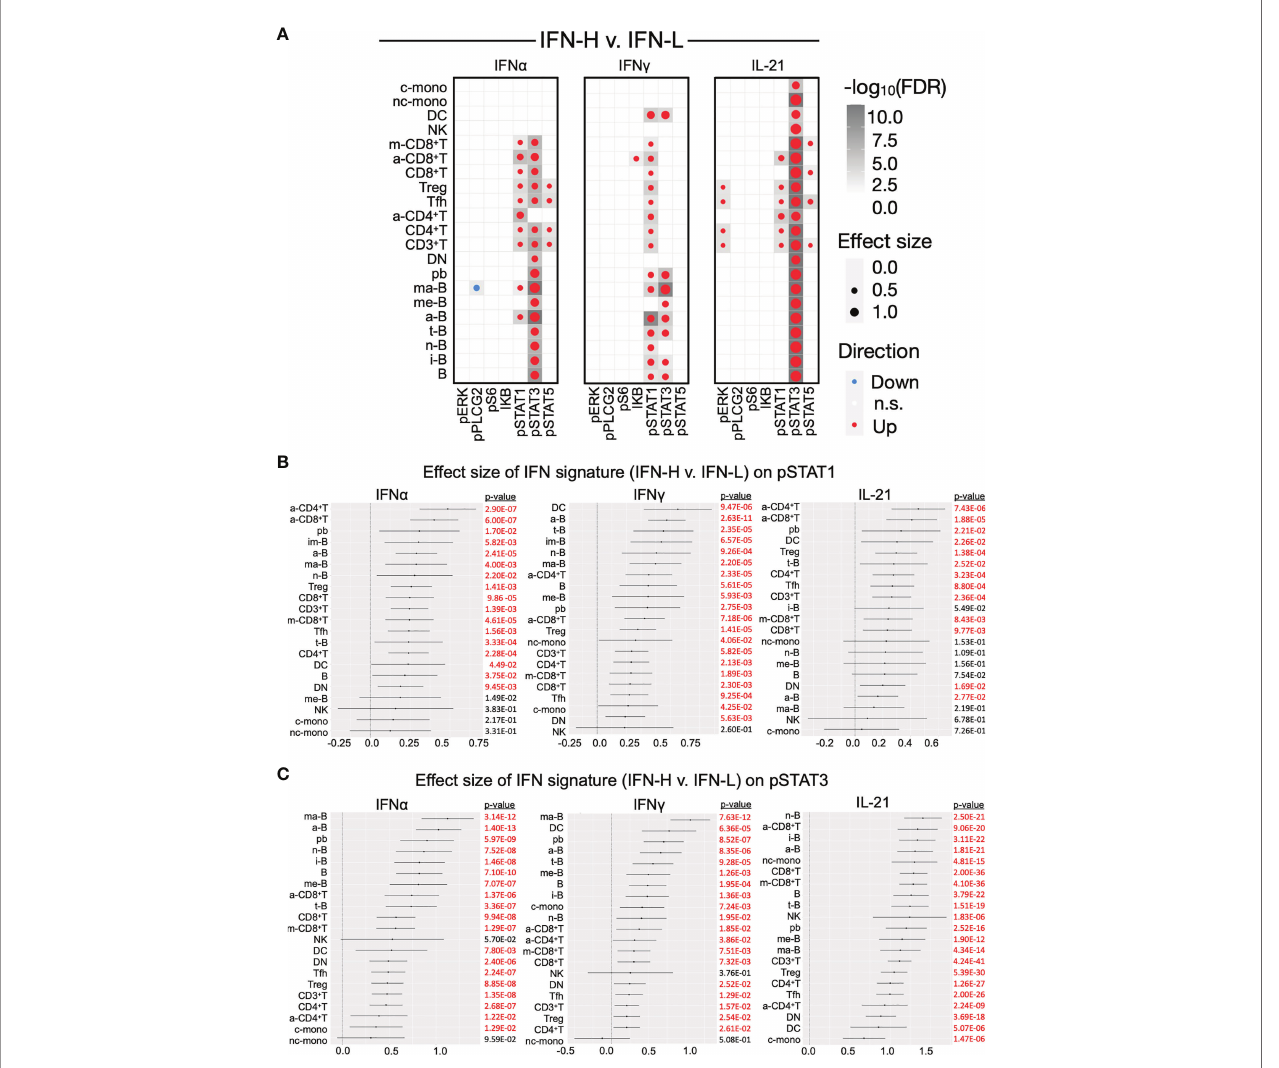
FIGURE 5 | (A-C) Effect sizes of IFN signature on phosphorylated signaling in SLE PBMCs. (A) Dotmap represents effect size of IFN signature (IFN-H v. IFN-L patients) on signaling protein (columns) across cell subsets (rows) after stimulation with IFN a (left), IFN g (middle), or IL-21 (right). Dot size depicts effect size, larger dots have greater effect sizes. Color depicts direction of effect size, red indicates positive effect size and blue indicates negative effect size. Shading of each box depicts statistical signi fi cance by -log10(FDR), darker boxes indicate greater statistical signi fi cance. Only cell populations with FDR < 0.05 are displayed in the dotmaps. Cell subsets (rows) are pre-de fi ned by marker intensity (Supplementary Table 3) . (B, C) Forest plots representing the effect size of IFN signature (IFN-H v. IFN-L) on phosphorylation of pSTAT1 (B) and pSTAT3 (C) in cell subsets downstream of IFN a (left), IFN g (middle), or IL-21 (right) stimulation. See Supplementary Figure 3D for forest plots for pSTAT5. Signi fi cant (p<0.05) effect sizes in red and not signi fi cant effect sizes in black. P values were adjusted using Benjamini- Hochberg false discovery rate